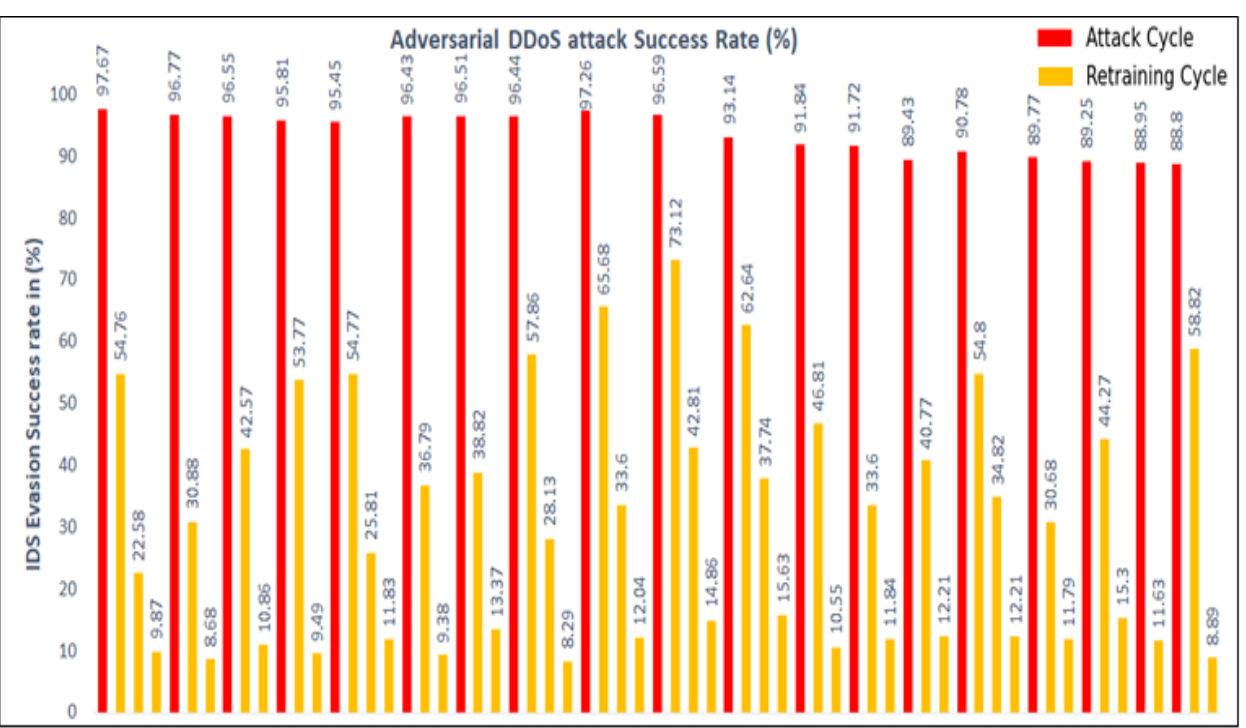
Figure 9. Polymorphic adversarial attacks using the manual feature selection (20 features).